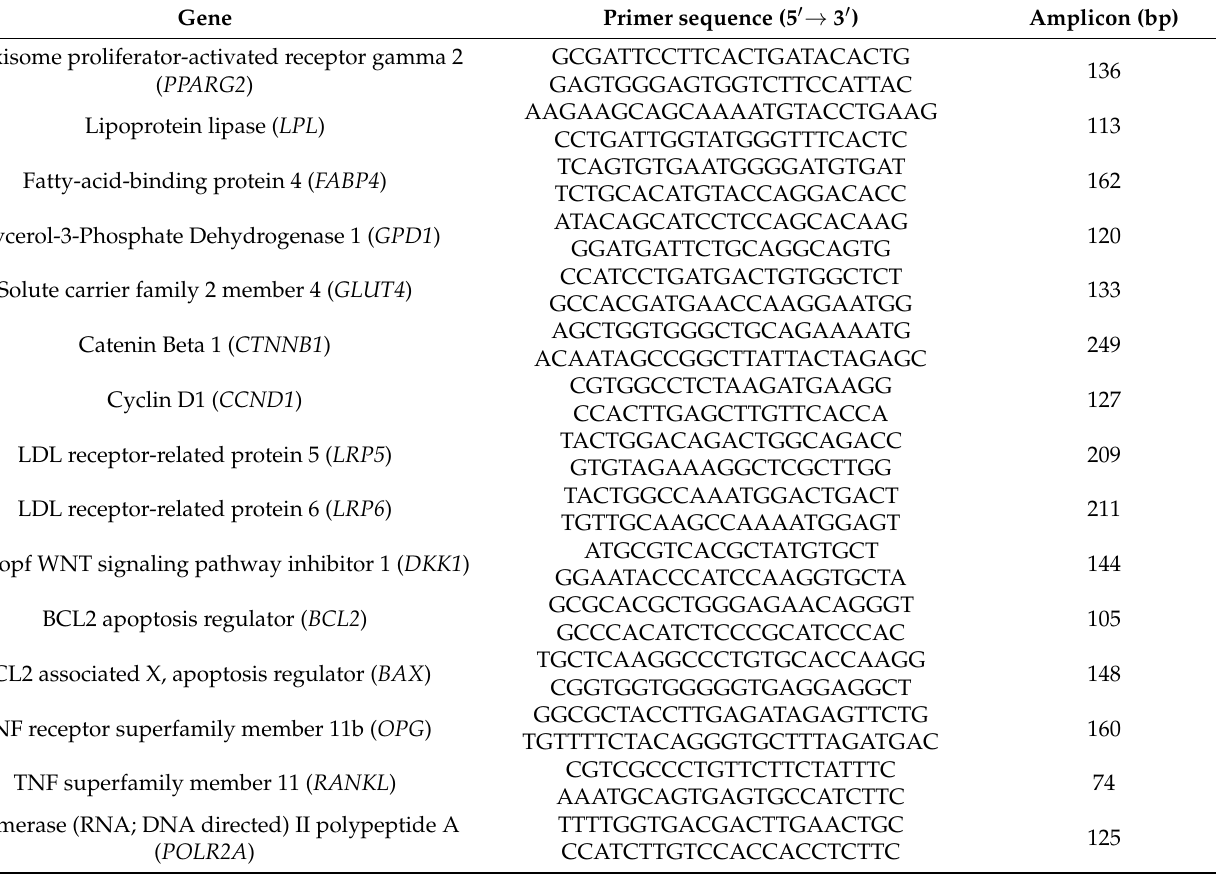
Table 1. Primer sequences and product